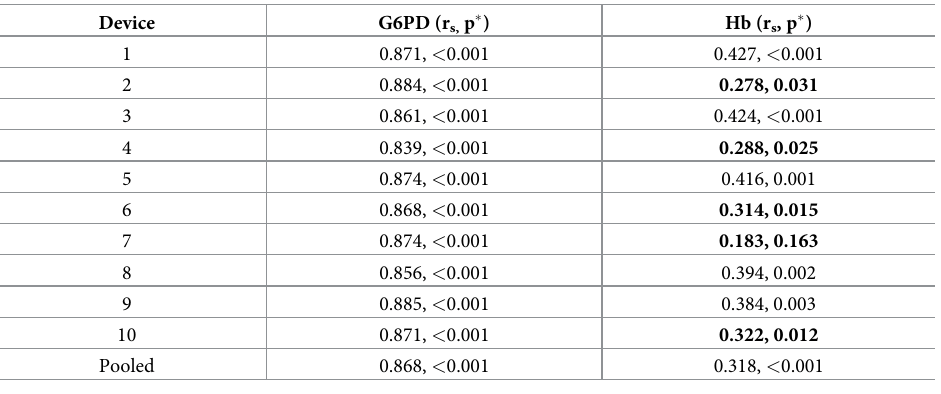
Table 1. Correlation of Biosensor and reference method, Phase